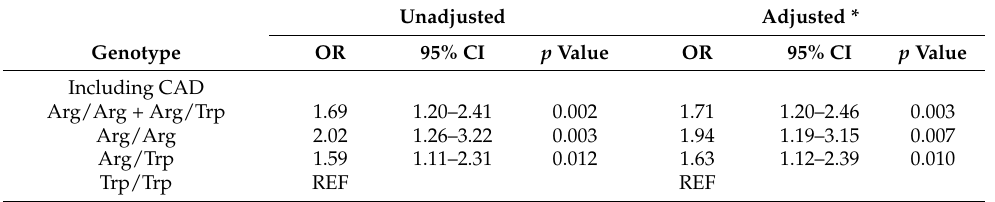
Table A5. Association of KIF6 719Arg with thoracic aortic dissection (only typical